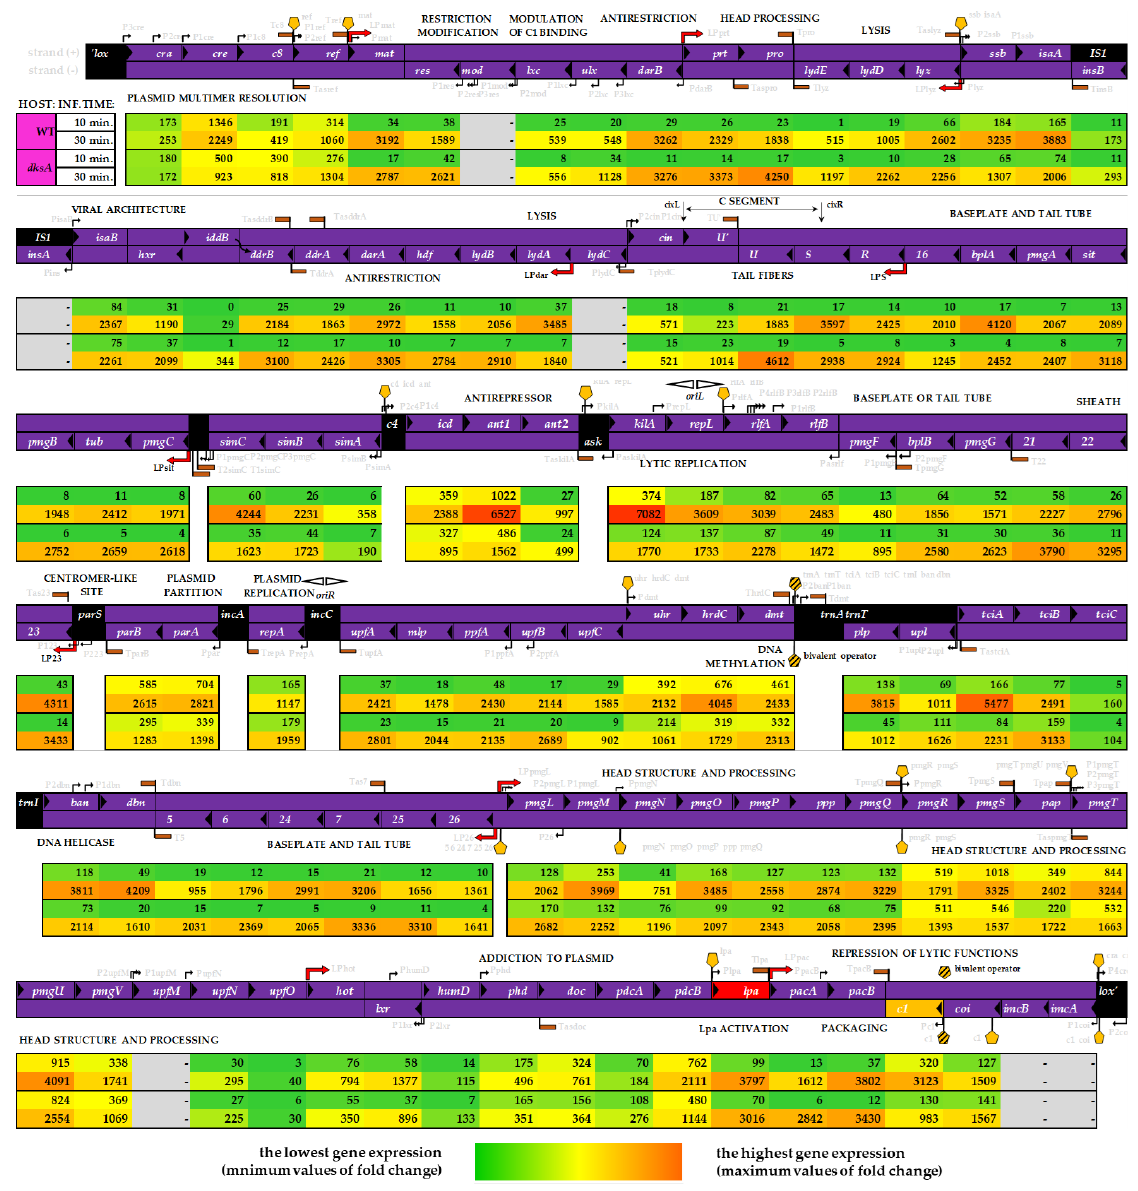
Figure 2. P1 vir bacteriophage gene expression presented on the genome map. Purple ribbons indicate both coding strands (+/ − ); black triangles inside ribbons are pointing at a given gene’s transcription start site. P1 vir transcriptome analysis upon infection is shown below the genome map. Gene expression fold changes are shown as values and heatmaps—the first two rows present data for the phage infecting the wild-type strain, and the next two rows present data for the phage infecting the dksA mutant; 10 min and 30 min post-infection, respectively. Several P1 genetic features are shown (gray description): σ 70 promoters (black arrows); Lpa-dependent promoters (thick red arrows); C1 operator sites (yellow pentagon, patterned if C1 binds at dual sites) Rho-independent terminators are marked with brown flags; sequences other than protein-coding or intergenic regions are shown as black boxes; lytic and plasmid replication origins are shown as white arrows above the genome map. Depicted gene lengths are not proportional to their actual